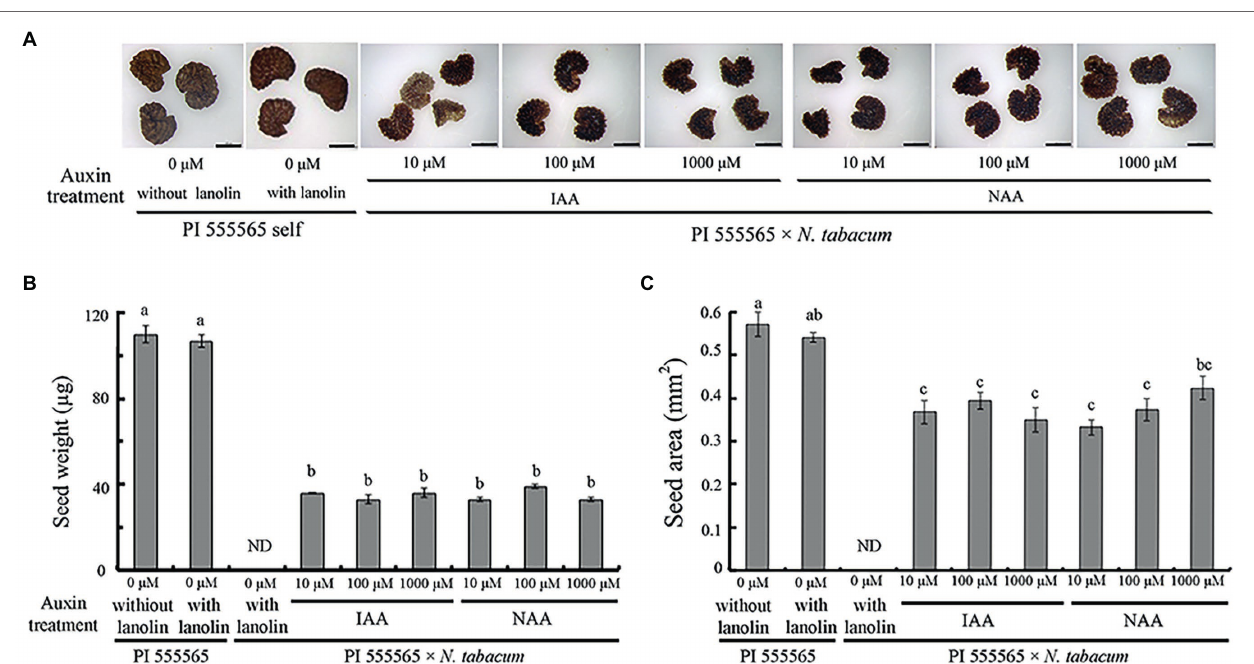
FIGURE 1 | Aborted seeds after auxin treatment in the cross Nicotiana suaveolens PI 555565 (8x) × Nicotiana tabacum . (A) Appearance of normal seeds produced by the self-pollination of PI 555565 and aborted seeds from the interspecific cross. Scale bars = 500 μ m. (B) Single seed weight. (C) Surface area of seeds. Bars represent standard error. Different lowercase letters indicate significant differences at the 5% level as per Tukey’s test. ND, no data.